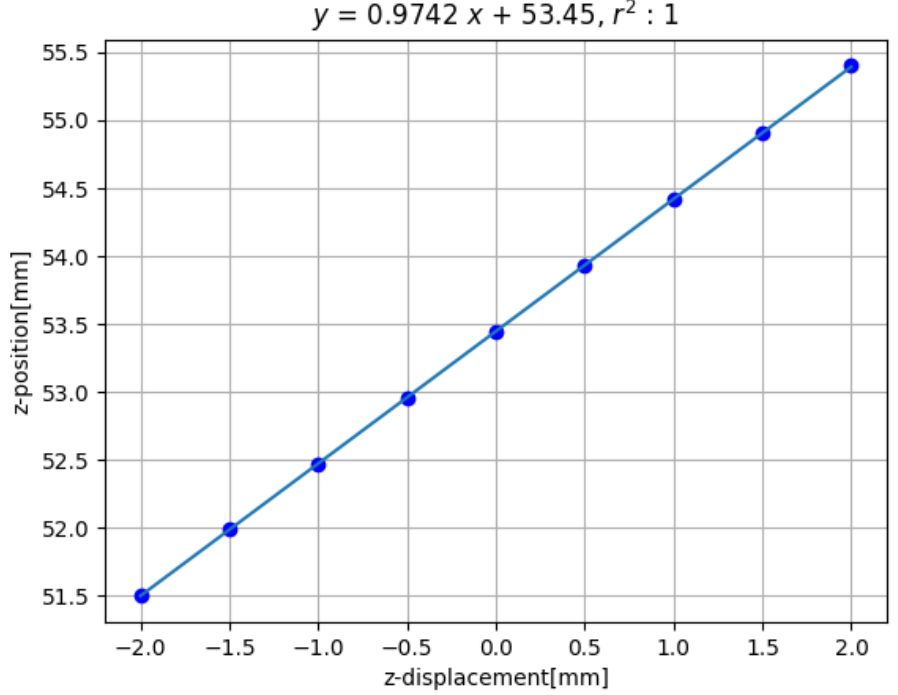
Figure 7. Result of estimation for z -axis displacement by method